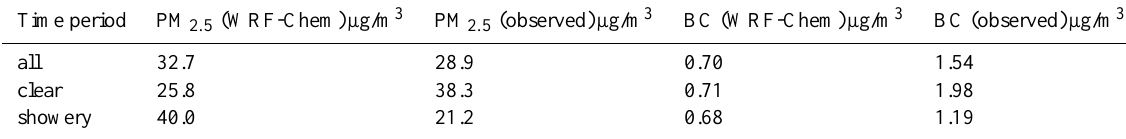
Table 3. Averaged concentration of PM 2 . 5 and BC for the periods indicated. The label “WRF-Chem” means that these are the concentrations predicted by the full, prognostic WRF-Chem